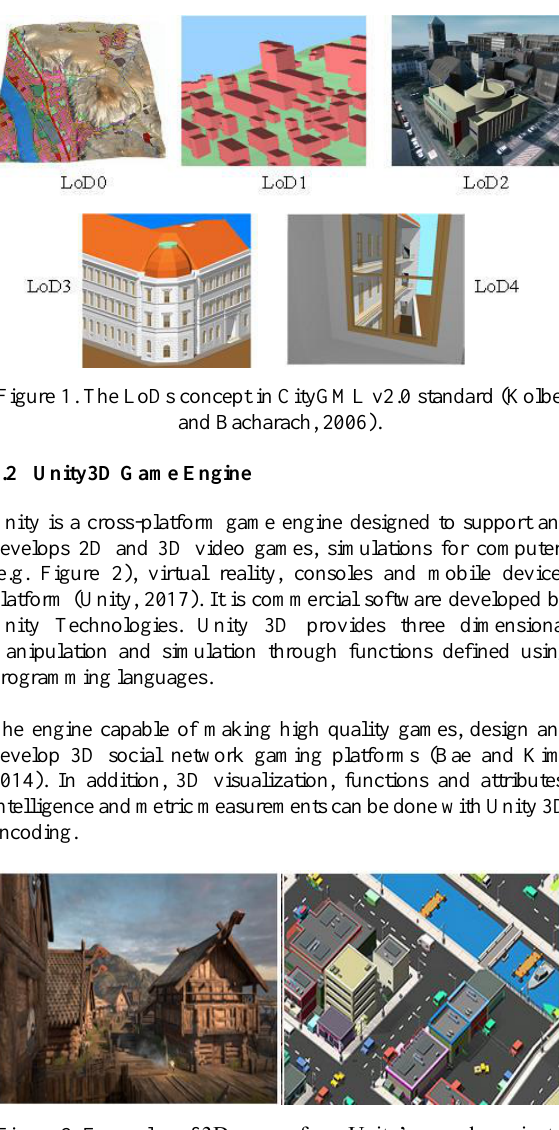
Figure 2. Examples of 3D scenes from Unity’s sample projects (Unity, 2017)